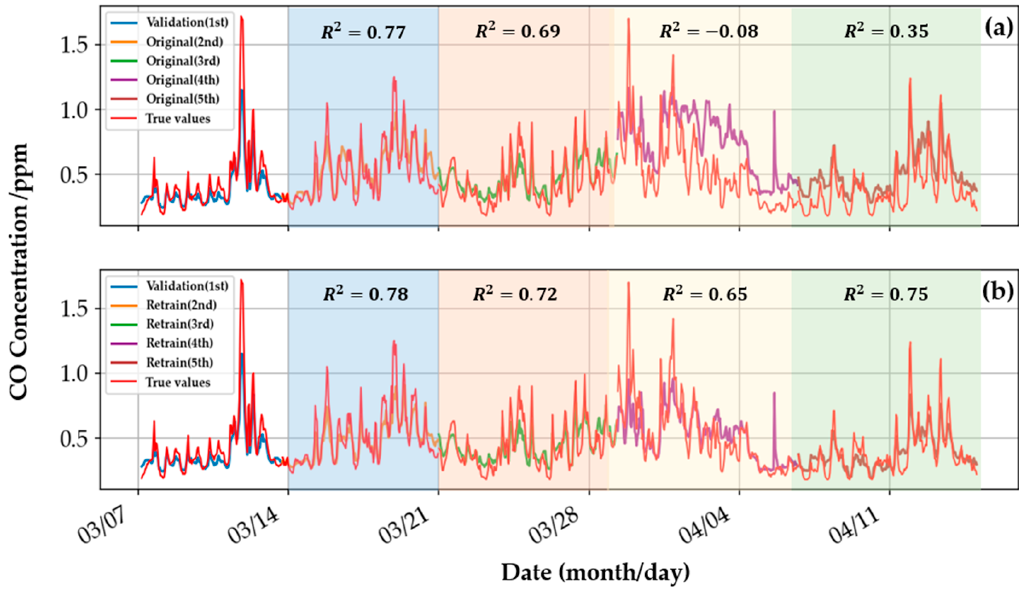
Figure 17. The performance comparison of the ( a ) original model and the ( b ) retrained model of the CO gas ensemble model at different periods. The true values of concentrations were from the EPA’s database. Table 5. Comparison of performance between original model and retrained model.